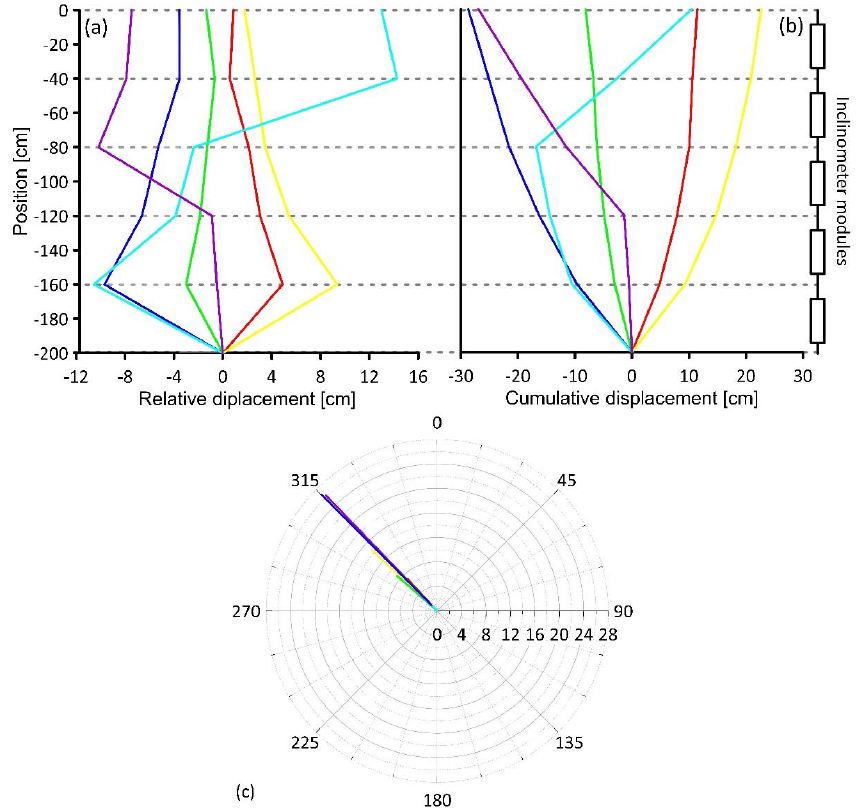
Figure 13. Graphs showing results from inclinometer measurements reproduced in the test. ( a ) Results in terms of relative displacement; ( b ) results in terms of cumulative displacement; polar graph ( c ) depicts the direction of cumulative displacement from the base to the head of the column.